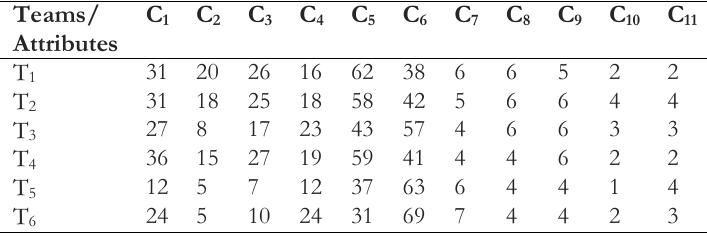
Table 1. Statically behavior of the collected data that is take up to 4 editions of the